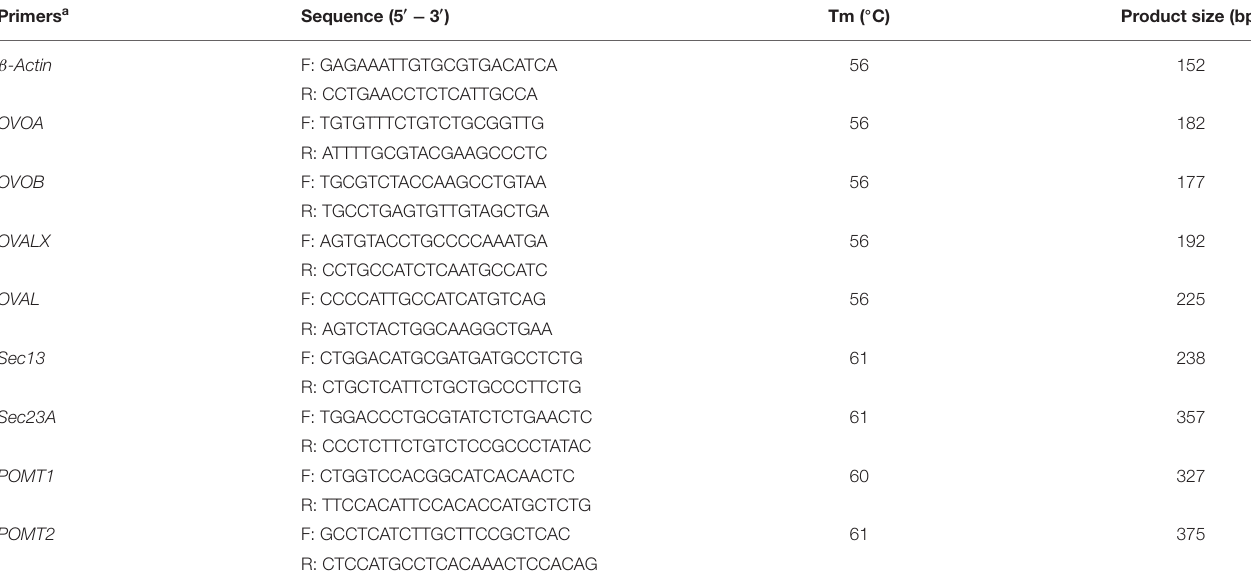
TABLE 2 | Information for primer sequences. Primers